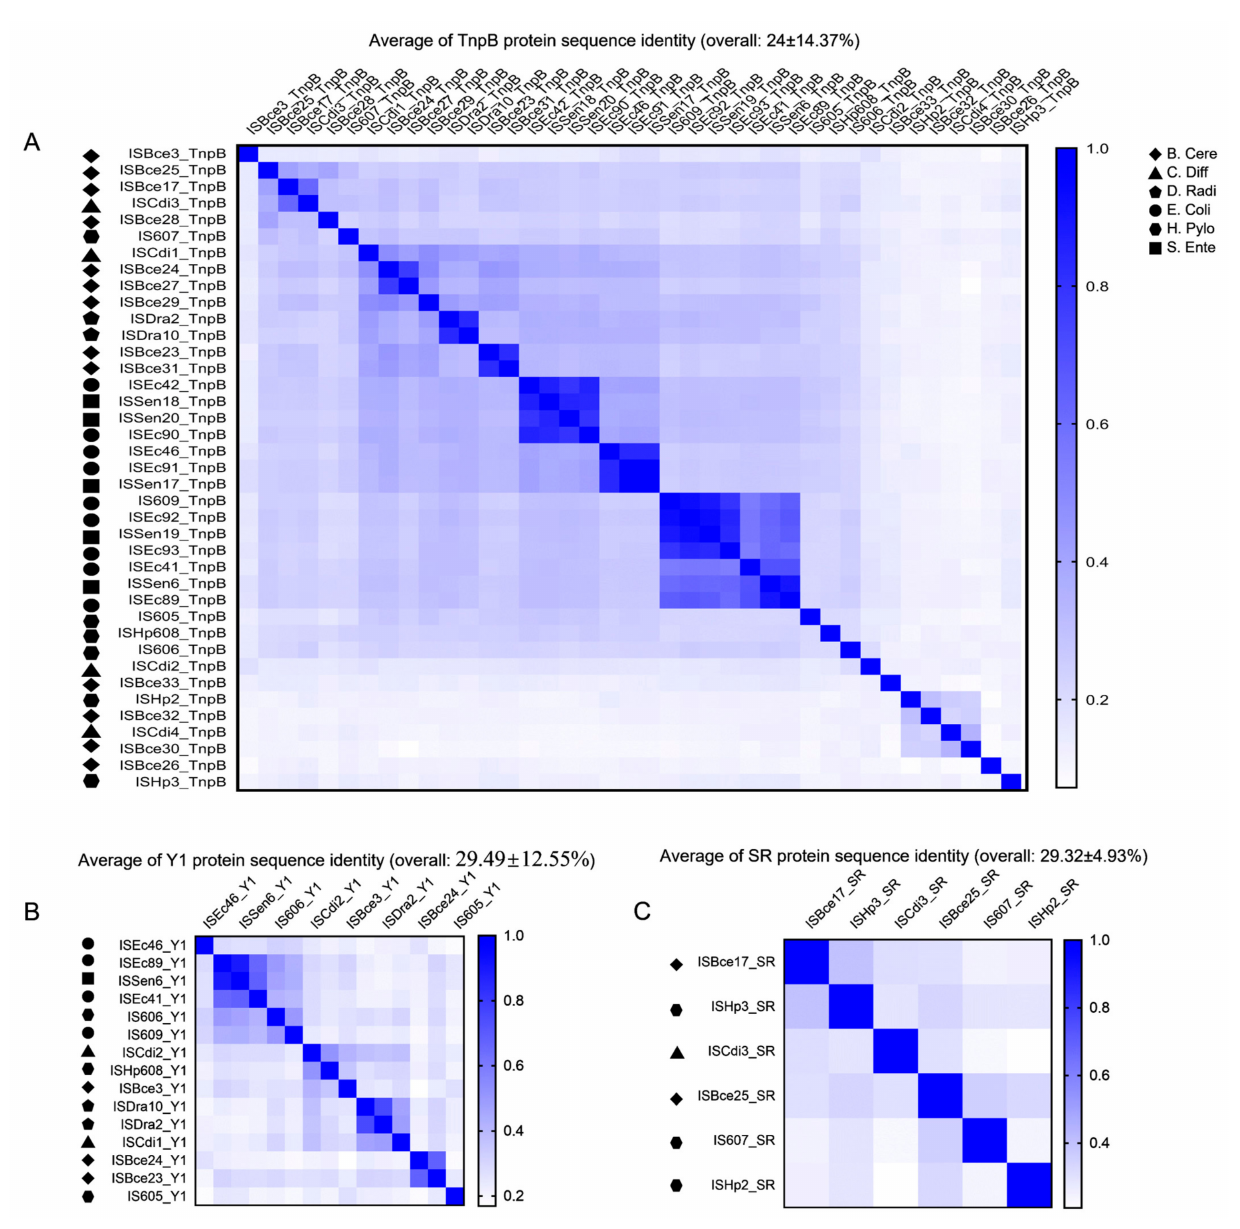
Figure 2. The overall identity of Y1, SR, and TnpB. ( A ) The identity of 39 mined TnpB proteins in six species. ( B ) The identity of 15 mined Y1 proteins in six species. ( C ) The identity of 6 mined SR proteins in six